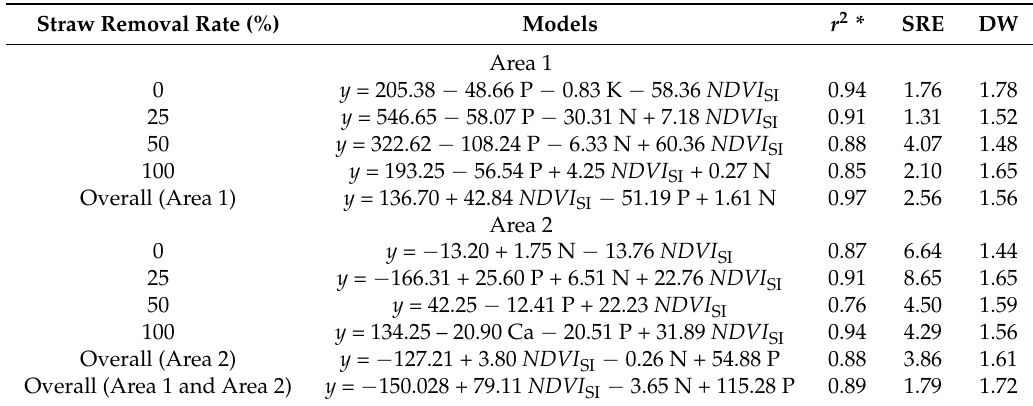
Table 4. Stepwise models for estimating the components of sugarcane yield under straw removal rates in Areas 1 and